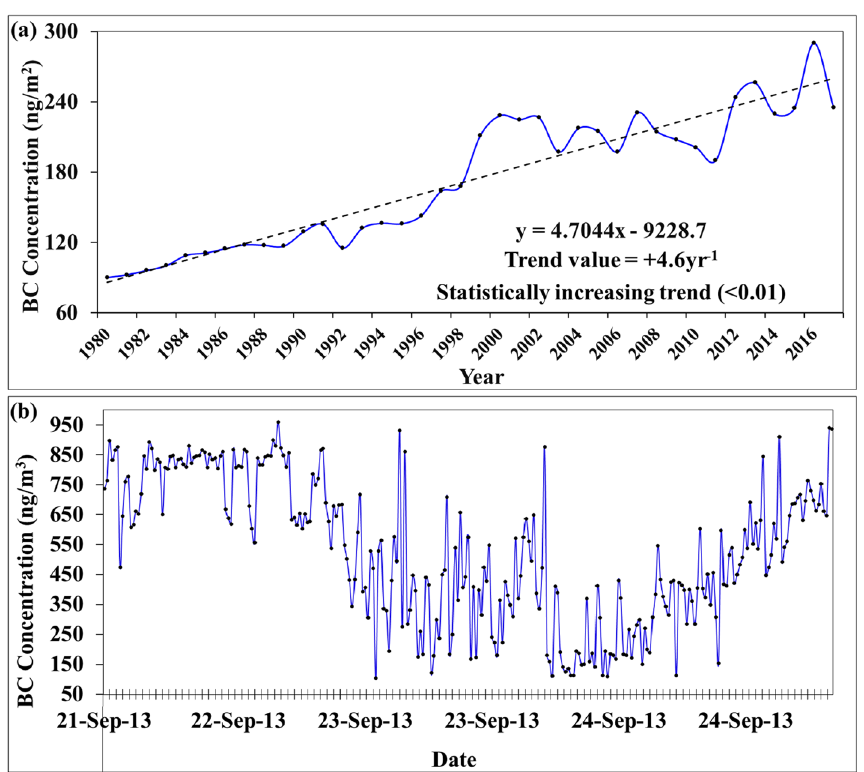
Figure 7. ( a ) Variation of the area-averaged MERRA BC concentration in the Lidder valley from 1980 to 2017, and ( b ) variation of the observed BC concentration at the ablation zone of the HG from 21 to 24 September,